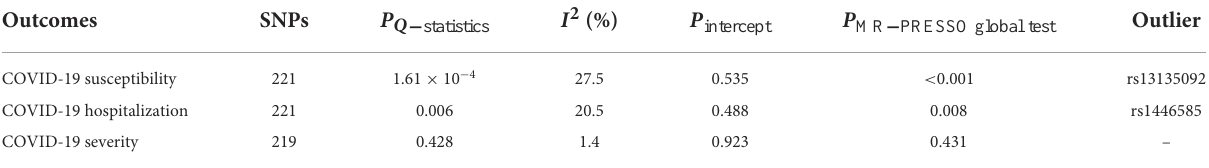
TABLE 2 Heterogeneity and pleiotropy assessment in primary analyses.